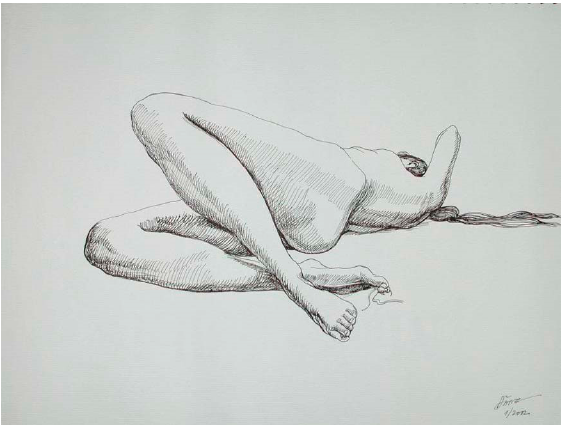
Figure A28. Khoa than 5 (Nude 5)—Nguyen Dinh Dang painted in 2002. The image was sourced from Thanh Nien Newspaper (Nguyen 2017b).